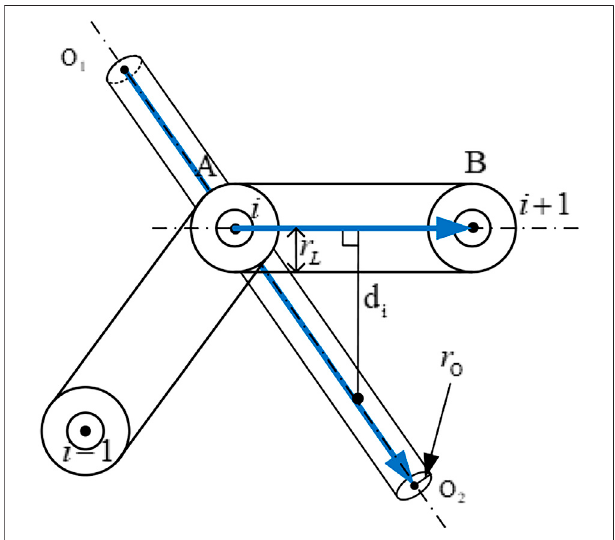
FIGURE 3 | Schematic diagram of the manipulator obstacle avoidance detection